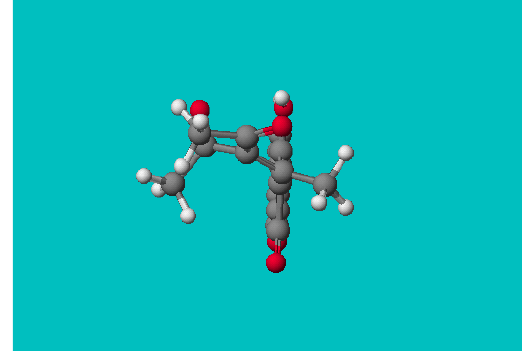
Figure 2 . PM5 geometry of 3-(1-(4-hydroxy-2-oxo-2H-chromen-3-yl)-ethylidene)-pentane- 2, 4-dione ( 6b